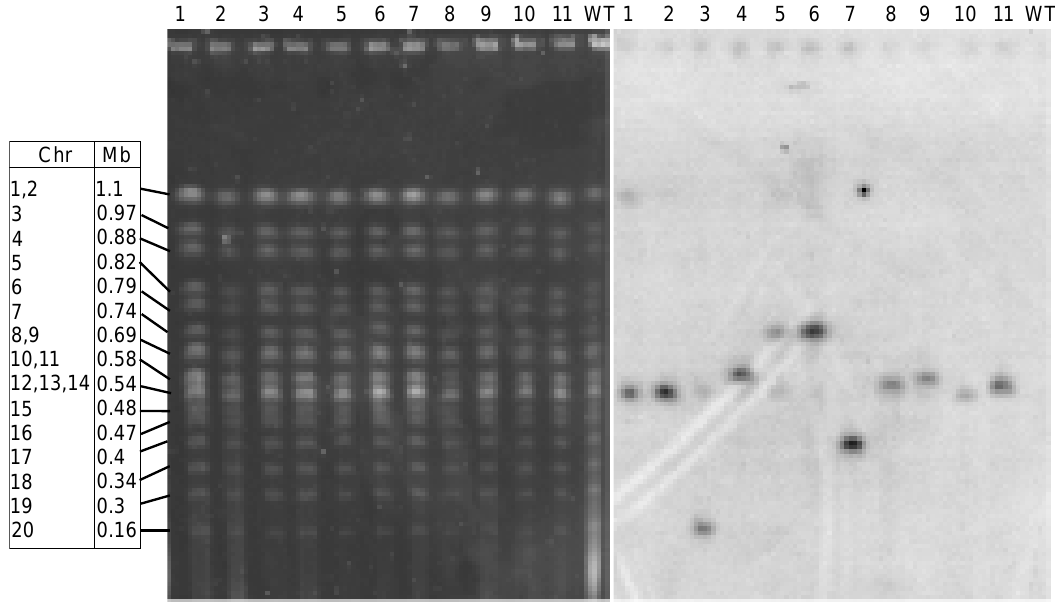
Figure 4. Karyotypes and integration of DNA in transformed lines. Pulsed-field gel electrophoresis (PFGE) separation of chromosomal DNA from Ostreococcus tauri lines. Left panel : fluorescence after staining the gel with ethidium bromide. Right panel : autoradiograph of the same gel probed with the coding sequence of the APH gene. WT: wild-type O. tauri strain RCC4221 non-transformed control. Numbered gel wells indicate transformed lines, each lane from a single clone. The table on the left displays chromosome number and chromosomal lengths in megabase pairs of the control WT strain.